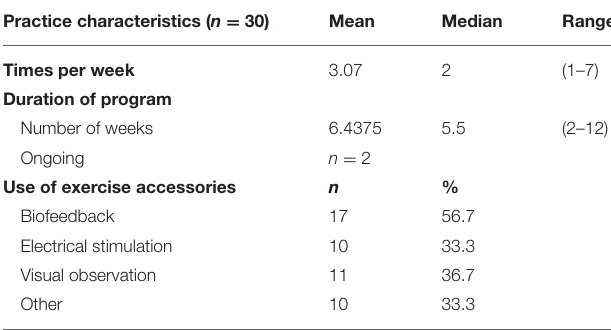
TABLE 4 | Pelvic floor muscle training